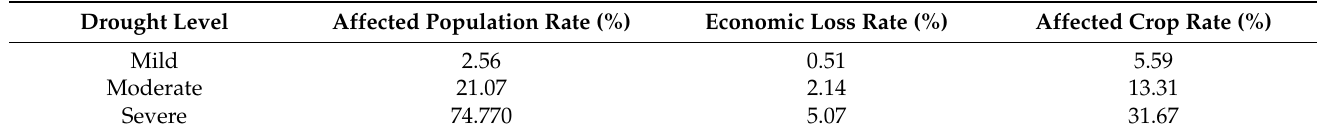
Table 4. Vulnerability to droughts of different levels in Cangnan County.